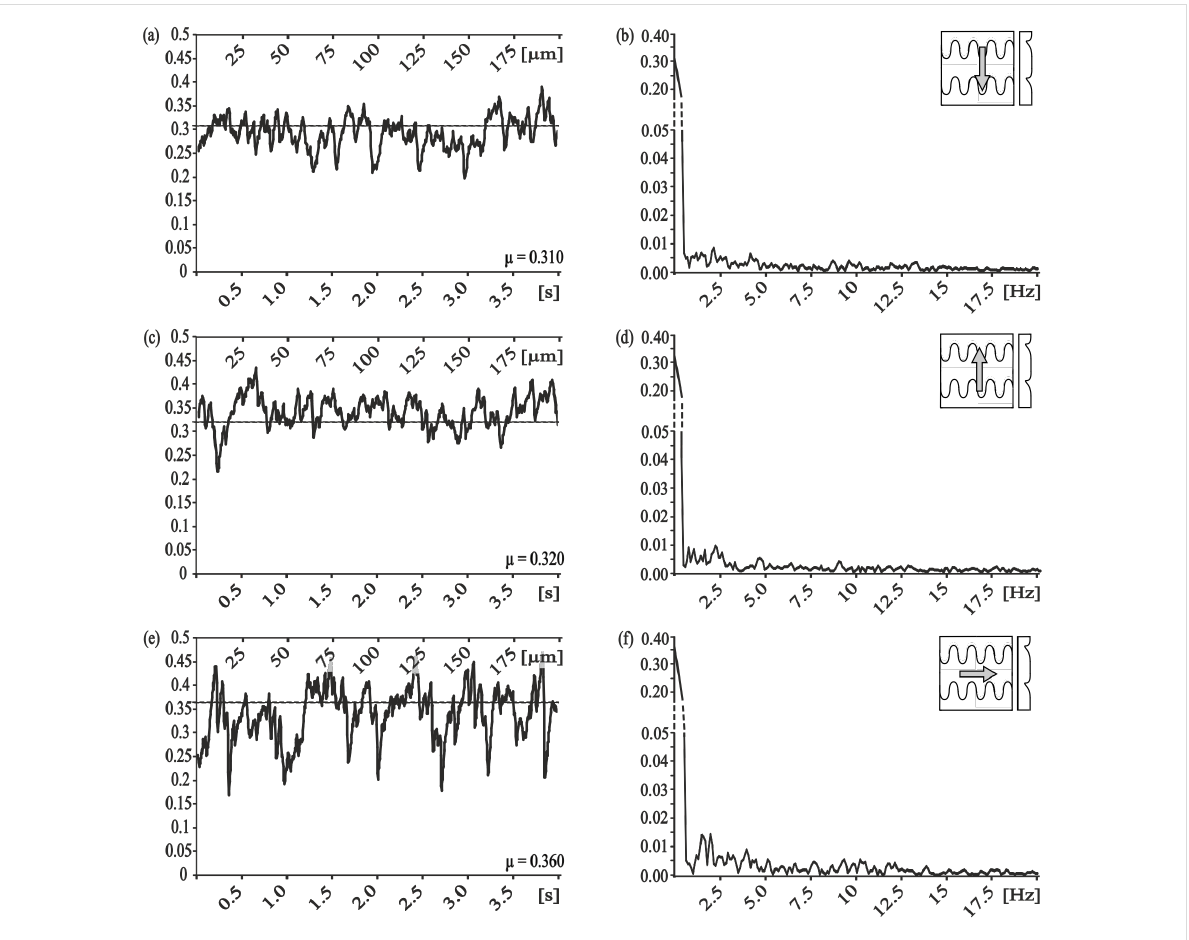
Figure 5: Frequency analysis of frictional coefficients measured on molds of snake skin ( L. g. californiae ) - PMLG. Left column, frictional signal in the spatial/time domain. Right column, frictional signal in the frequency domain after FFT; ordinate shows single-sided amplitude spectrum - SSAS. Measurement direction: a,b) along the microstructure, c,d) against the microstructure and e,f) lateral to the microstructure.